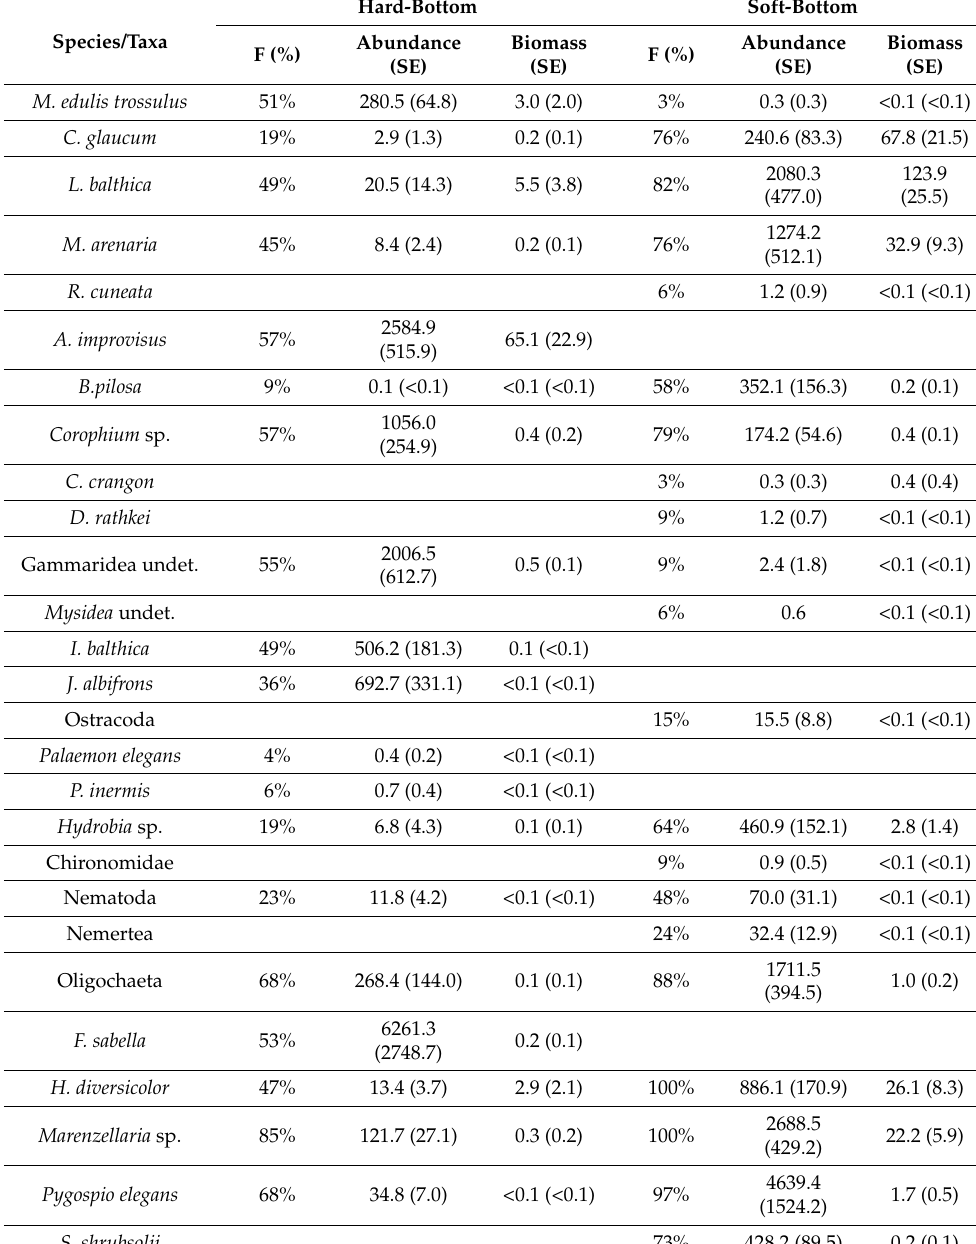
Table 2. Main characteristics of the macrofauna community in hard- and soft-bottom habitats, according to the data collected from 2014 to 2020. Abbreviations: F (%)—frequency; SE—standard error. Abundance and biomass are expressed in ind m − 2 and g m − 2 ,